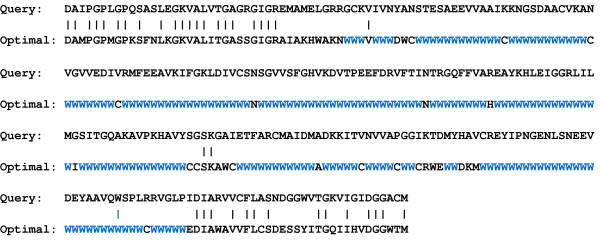
Query sequence 1ybvA aligned with the optimal sequence drawn from the PSI-BLAST profile The optimal sequences generated from the PSI-BLAST alignments have large stretches of tryptophan repeats that show where the profile has lost evolutionary information. Here the query sequence (above) is aligned with its optimal sequence. Repeated tryptophans in the optimal sequence are highlighted in blue.